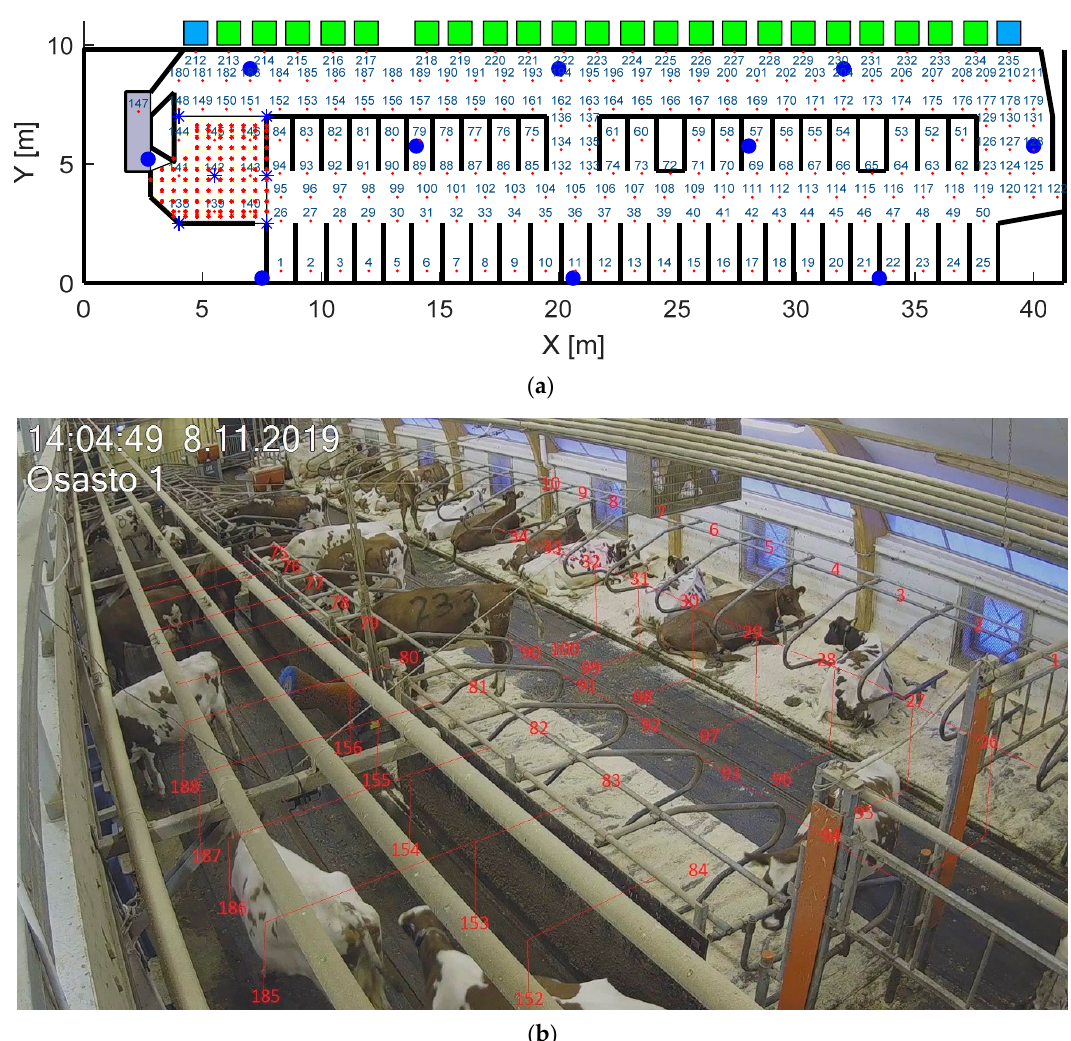
Figure 1. Components of the location and acceleration measuring system installed in a barn: RuuviTag inside a protecting plastic box ( a ), tag on the cow collar ( b ), receiving station installed on a barn construction ( c ).